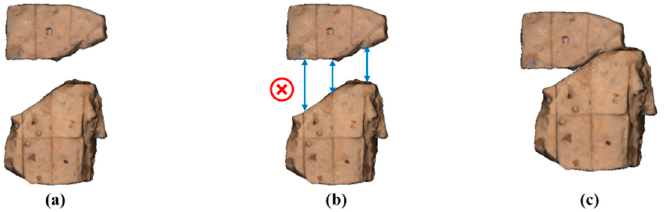
Figure 14. Judgment in severely damaged condition. ( a ) Two fragments; ( b ) judgment obtained by our SPPD method that the two do not match; ( c ) ground truth.